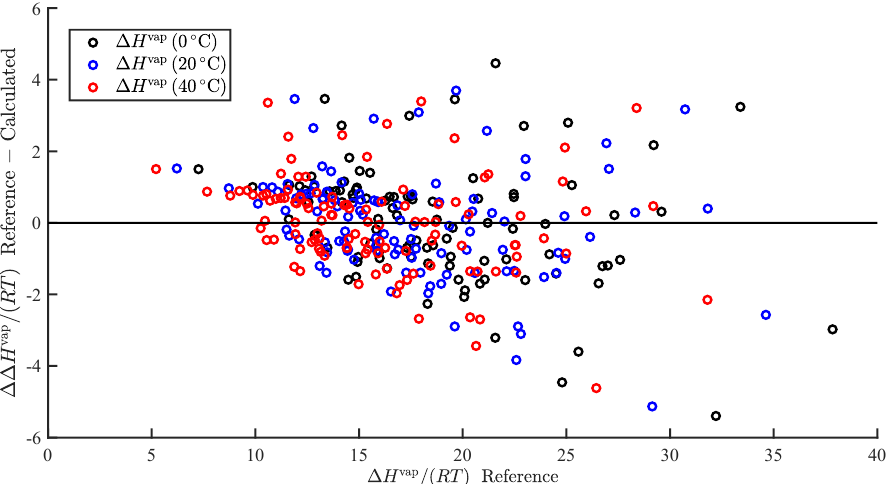
Figure 4. Residual plot of the difference between the reference and calculated (using Equation (14)) values of the dimensionless ∆ H vap / ( RT ) at 0, 20, and 40 ◦ C, as indicated, versus the reference values. The solid line corresponds to the y = 0 line and is drawn as a